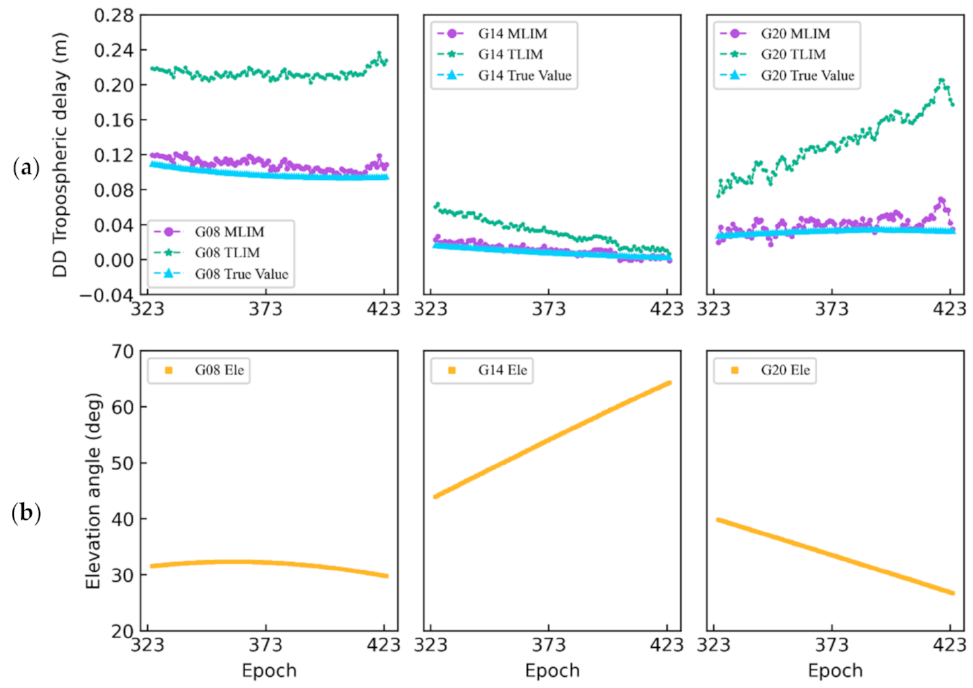
Figure 7. The DD tropospheric delay obtained by different methods ( a ) and elevation angles ( b ) for satellites G08, G14, and G20 at the rover station